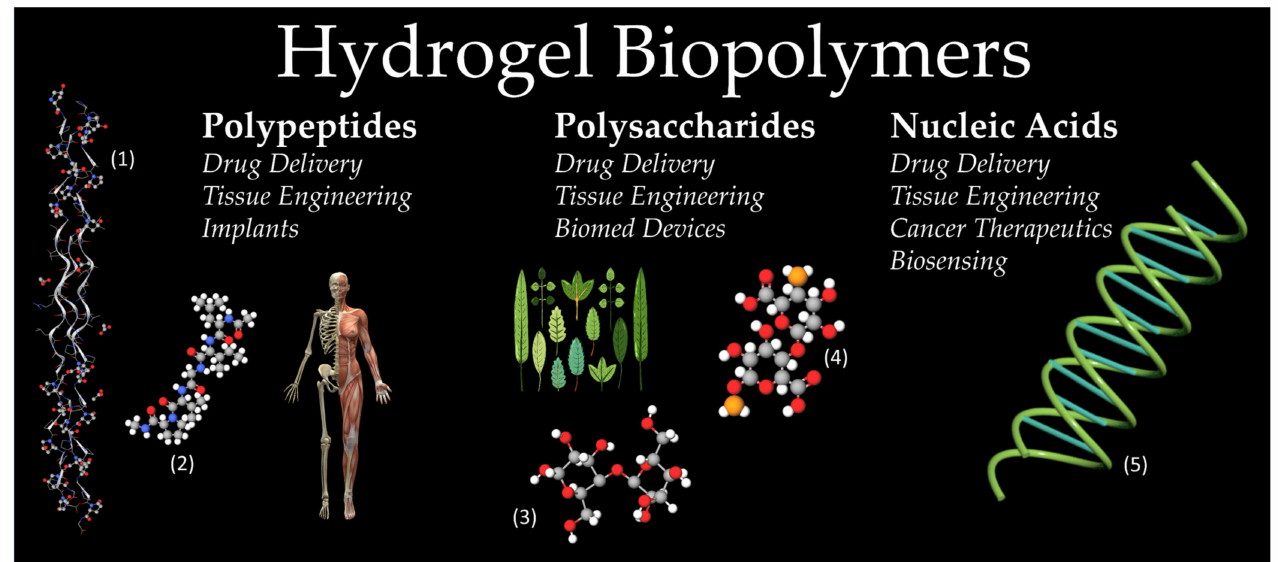
Figure 1. Examples of typical hydrogel biopolymers. Polypeptide column showcases collagen ( 1 ) and elastin ( 2 ) structures, which are found in musculoskeletal systems. Polysaccharide column shows the cellulose ( 3 ) structure and alginate ( 4 ) structures, as the majority of polysaccharides are derived from plant life. A double-helix DNA molecule ( 5 ) is shown as a typical nucleic acid. (Images of the musculoskeletal system and the plant life are open source provided by pixabay.com, and images of collagen, elastin, cellulose and alginate are open source provided by